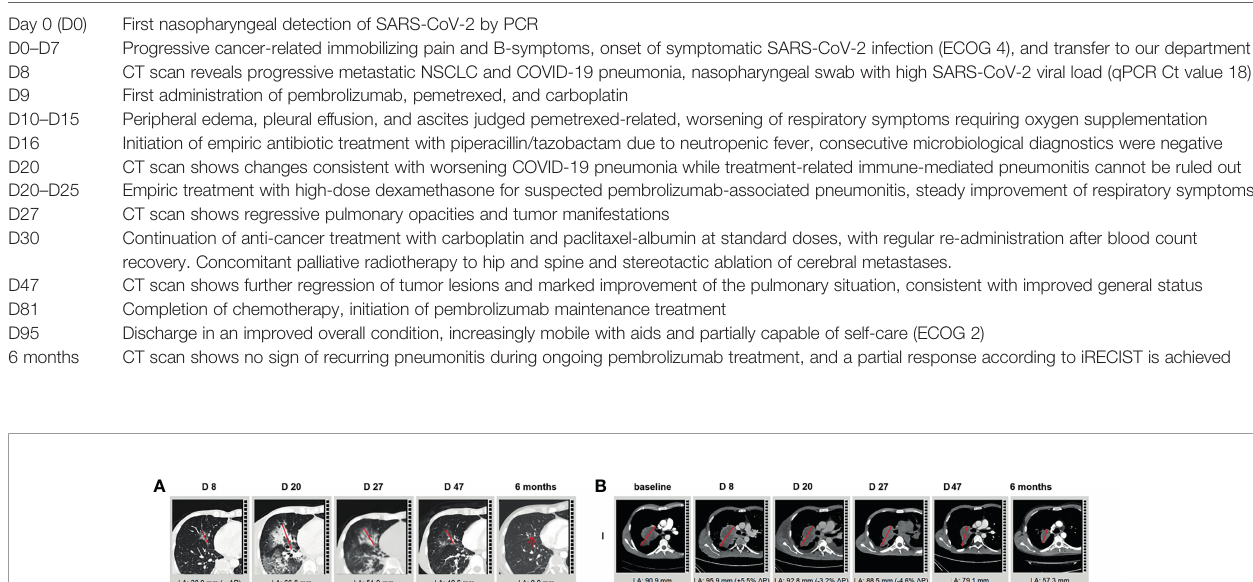
TABLE 1 | Timeline of the episode of care.